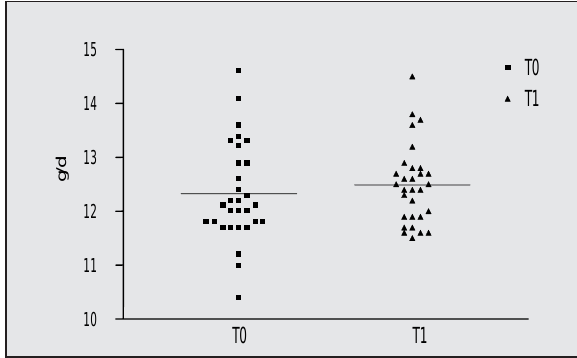
Figura 1 – Distribuição dos valores de eritrócitos das pacientes antes (T0) e após (T1) a terapia de reposição hormonal. Verifica-se redução significativa ( p < 0,05) da contagem absoluta de eritrócitos após o tratamento. A barra horizontal representa a média